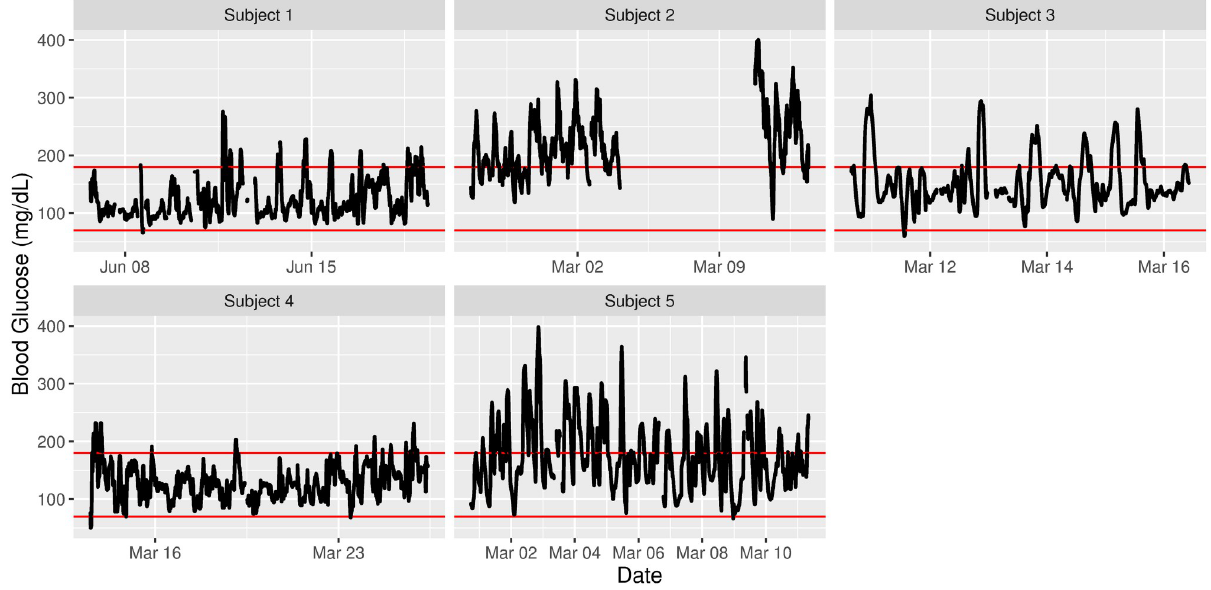
Fig 1. Time series plots for five subjects. Selected target range is [70, 180] mg/dL. https://doi.org/10.1371/journal.pone.0248560.g001 The midpoint specifies the glucose value (in mg/dL) at which the color transitions from blue to red (the default is 105 mg/dL), whereas the limits specify the range (the default is [50, 500] mg/dL). From Fig 2 one can for example infer that the glucose values for Subject 1 tend to be the highest in late afternoon ( � 15:00—20:00). One can also infer that Subject 1